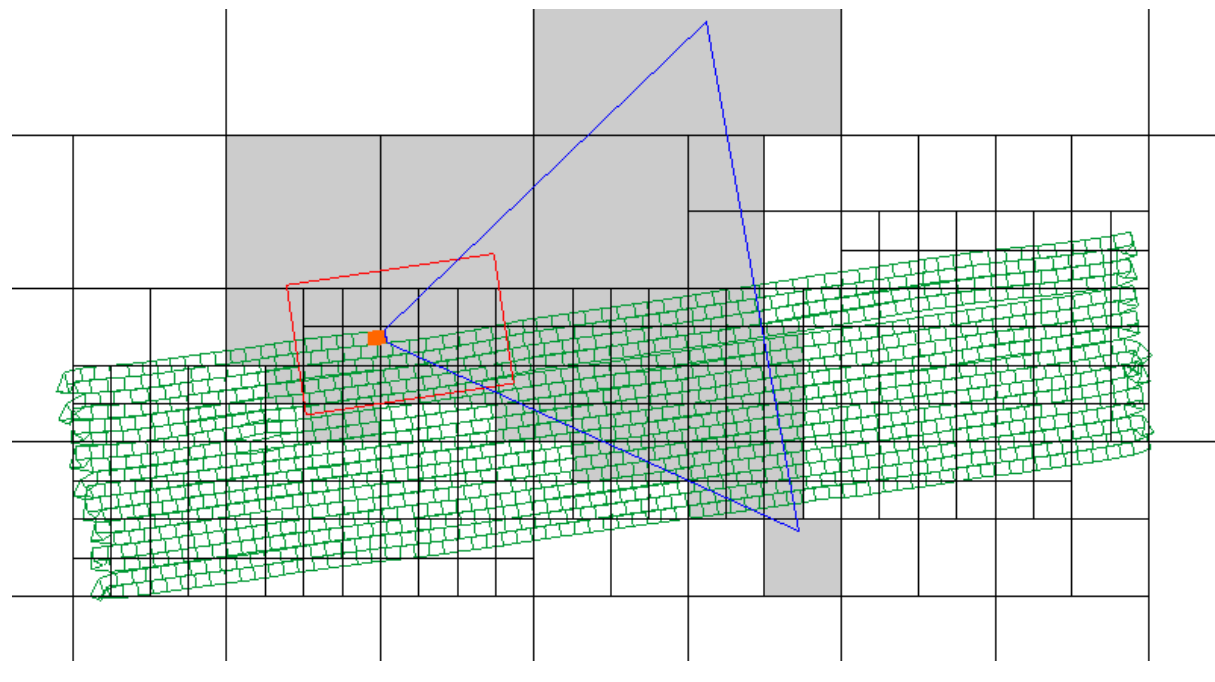
Figure 5. Screen capture of a quadtree visor developed to preview the quadtree